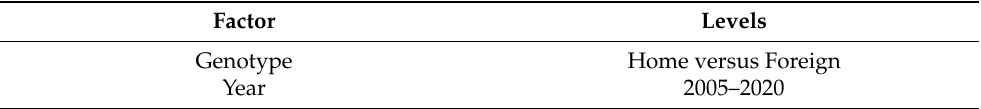
Table 1. Experimental set-up for two-way factorial in each of two experimental sites in reciprocal transplant study. Factor Levels